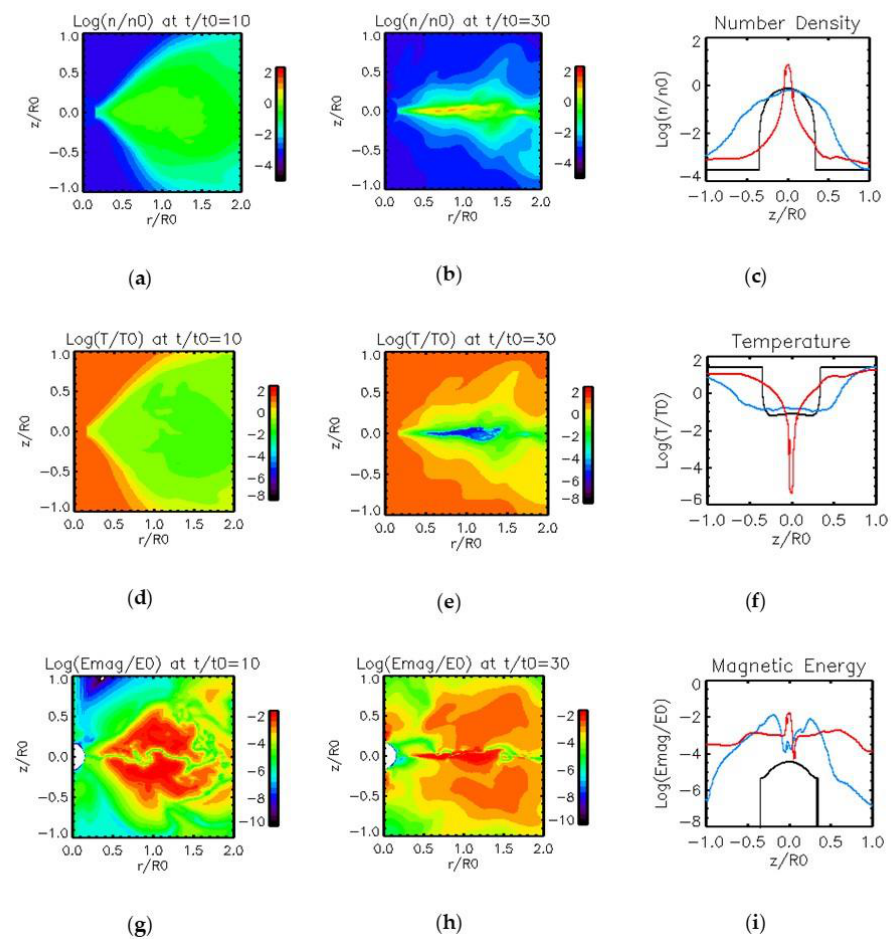
Figure 2. Results of Model 2. Same quantities and conditions of visualization as Figure 1.